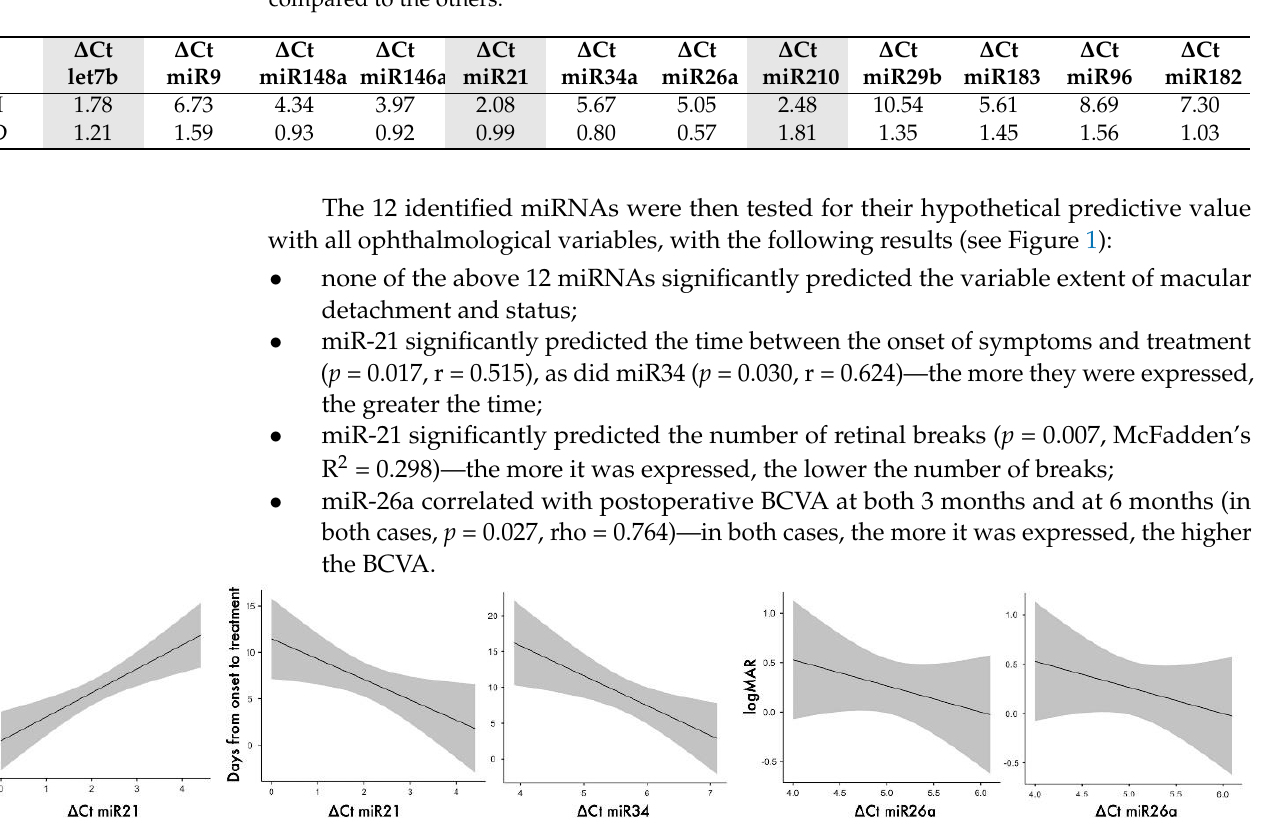
Table 2. Expression of the 12 miRNAs in the analyzed SRF samples. Values are reported as mean (M) and standard deviation (SD). Grey columns indicate those miRNAs whose expression was greater compared to the others.